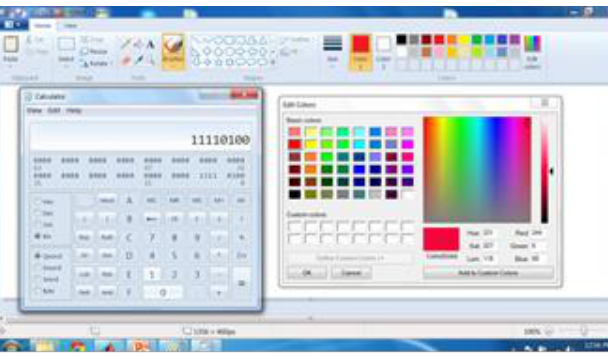
Figure 4. Original color intensity